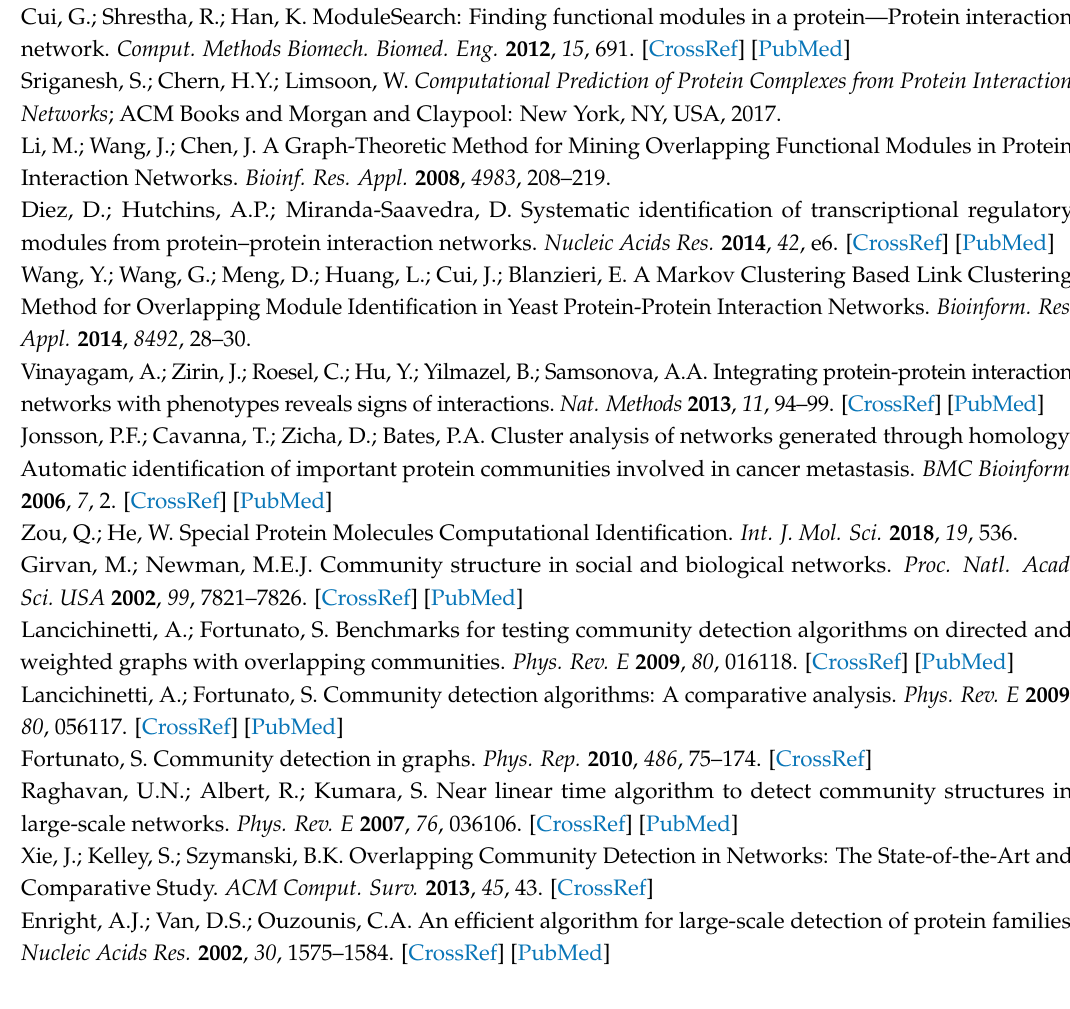
Supplementary Materials: Figure S1: Comparison of three levels on M. musculus Network, Figure S2: Comparison of three levels on E. coli Network, Figure S3: Comparison of three levels on Cerevisiae Network. Author Contributions: Conception and design of experiments: L.H., Y.W., and Q.M.; Conduction of experiments: F.Z., Y.W., A.M., and Z.W.; Data analyses: F.Z., A.M., and Y.W.; Manuscript draft: Y.W., L.H., F.Z., A.M., Z.W., B.L., and